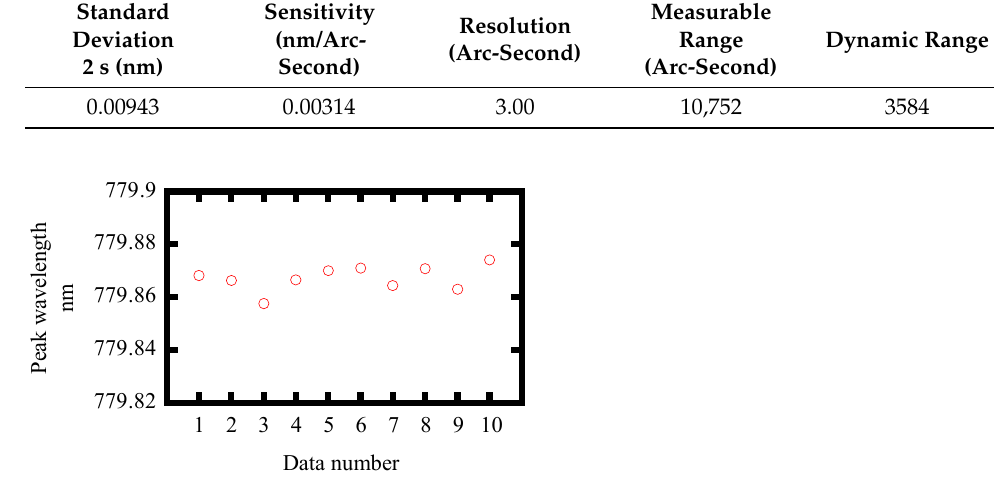
Figure 9. Experimental result of noise level using the standard deviation of the center-of-gravity wavelength calculation for each data point. Table 6. The characteristics of the angle measurement method in Table 5. The experimental results of the proposed angle measurement system.